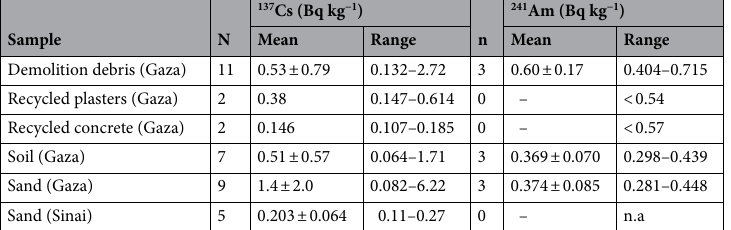
Table 4. The mean and range of activity concentrations of 137 Cs and 241 Am detected in the samples. n: number of samples in which radionuclide detected; ± : standard deviation. n.a.: not analyzed.